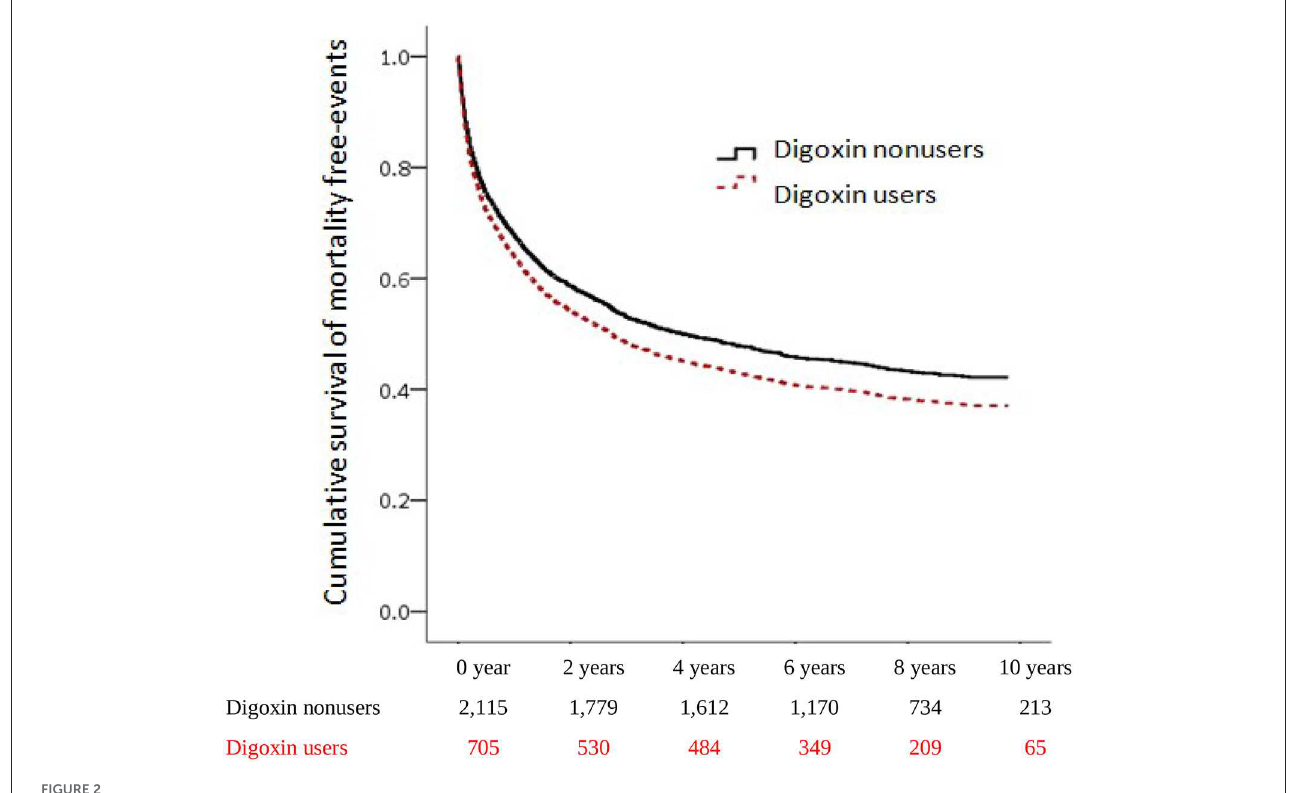
FIGURE2 Cumulative hazards of all-cause mortality among patients with CRS.